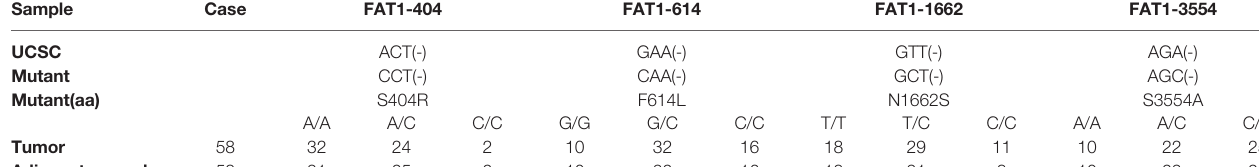
TABLE 3 | FAT1 mutation status among OSCC tissues, matched adjacent normal tissues, and leukocyte DNA of normal individuals.